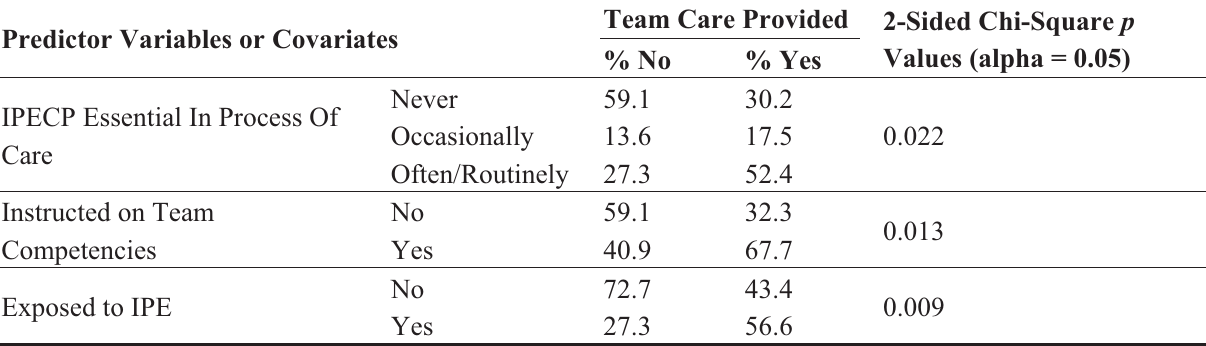
Table 6. Preliminary bivariate analysis with team care provided as outcome or dependent variable.